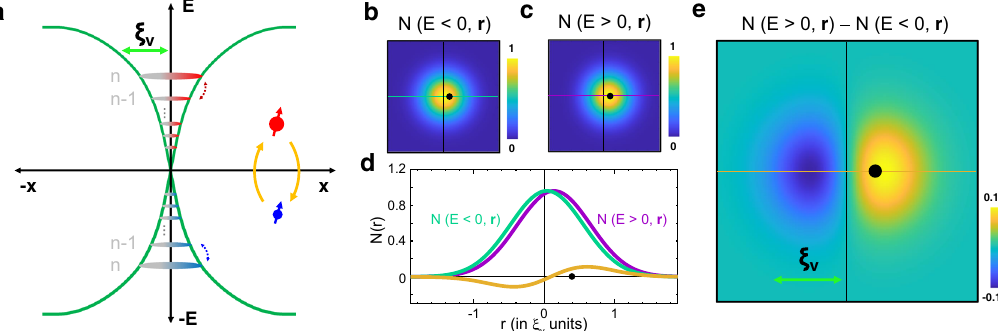
Fig. 1 Interaction between Caroli de Gennes Matricon (CdGM) and Yu Shiba Rusinov (YSR) states. a The YSR state is schematically represented by the red and blue dots with arrows representing the spin. The value of the superconducting gap as a function of the radius is shown in green for energies above and below the Fermi level. The CdGM states are schematically shown by colored circles. The difference in energy between levels, Δ 2 /2 E F , with Δ the superconducting gap and E F the Fermi energy, is strongly exaggerated. Green arrow on top schematically represents the vortex core size ξ V . The interaction between CdGM and YSR bound states leads to a spatial shift in the CdGM states, which is different for electron and hole components of the Local Density of States (LDOS) inside the superconducting gap, N ( E > 0) ( b ) and N ( E < 0) ( c ). In d we show line pro fi les of the images in b (blue-green) and of c (magenta). We also show a pro fi le of their difference in orange. In e we show the difference image between b and c . The LDOS is larger along the direction of the YSR impurity. This occurs for a hole band and a single impurity. For an electron band, we expect the opposite result. The position of the YSR impurity is represented by a black dot and the vortex core center by the crossing point between lines in b , c , d , and e